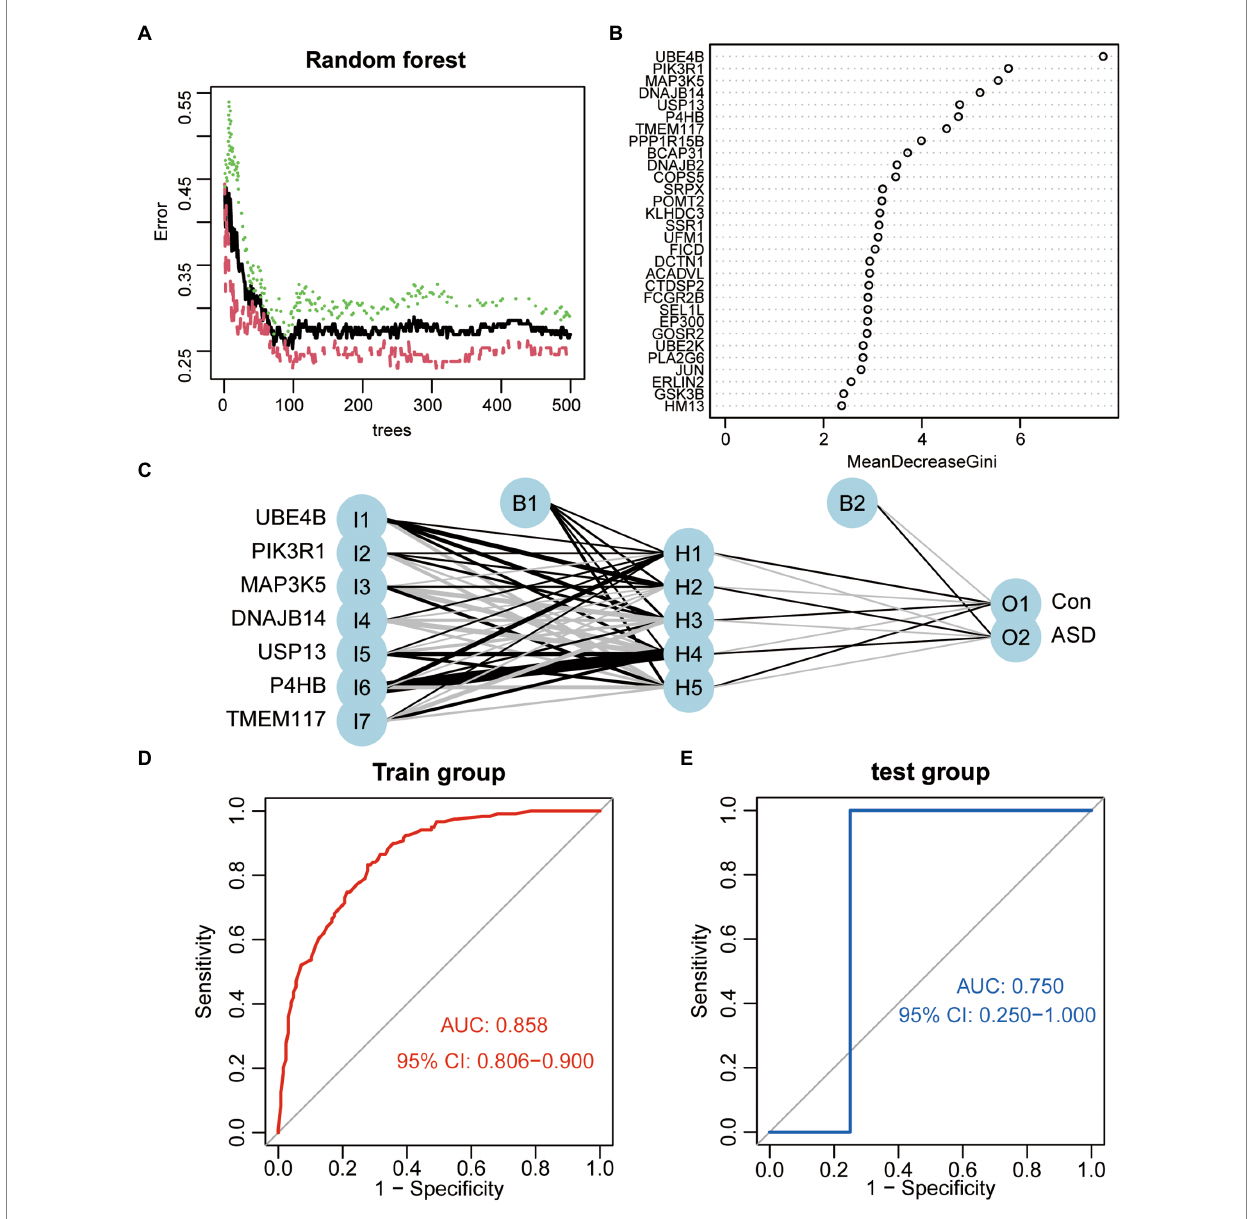
FIGURE 2 Construction of the ASD classifier. (A) The average error rate of random forest model. (B) Variable importance ordered by the gini index of a mean decrease in random forest. (C) The schematic diagram of artificial neural network model. (D) ROC curves show the AUC values of the ASD classifier in GSE111176. (E) ROC curves show the AUC values of the ASD classifier in GSE77103. (F) ROC curves show the AUC values of the ASD classifier in